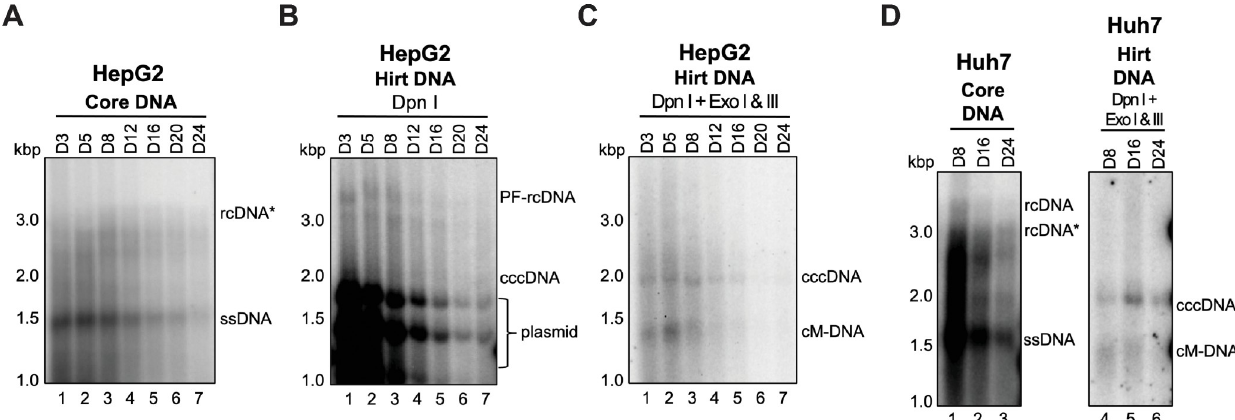
Fig 2. Human hepatic cell lines supported WHV cccDNA formation after transfection. Human hepatoma HepG2 cells were transfected with a WHV replicon, and cells were harvested at the indicated time points for analyzing core DNA (A) and Hirt DNA with Dpn I treatment (B) or with Dpn I plus Exo I/III treatment (C). The same experiment was repeated in another human hepatoma cell line Huh7 (D). ssDNA, single-strand DNA; rcDNA � , rcDNA with incomplete minus strand; cM-DNA, closed minus strand circular DNA.